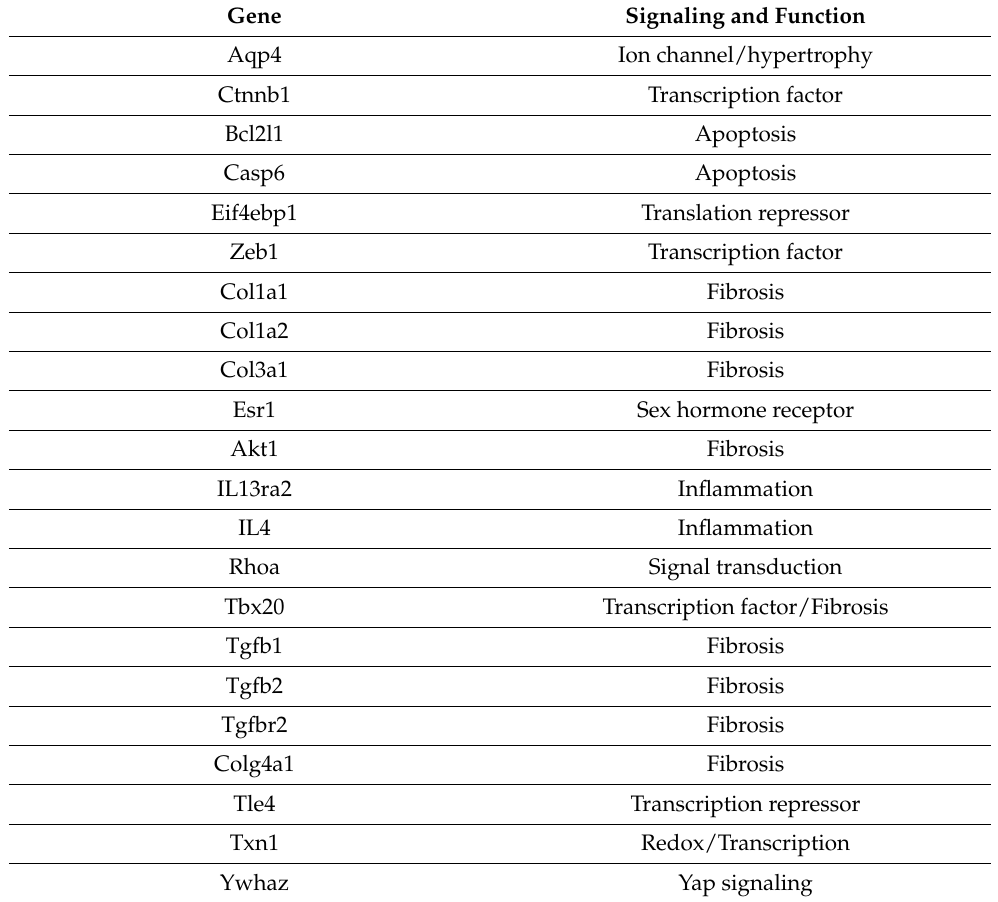
Table 1. Top identified genes from RNA array